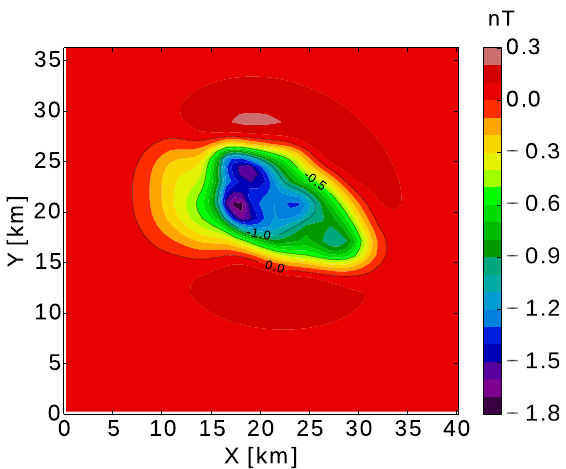
Figure 12. Magnetic anomaly corresponding to salt body.